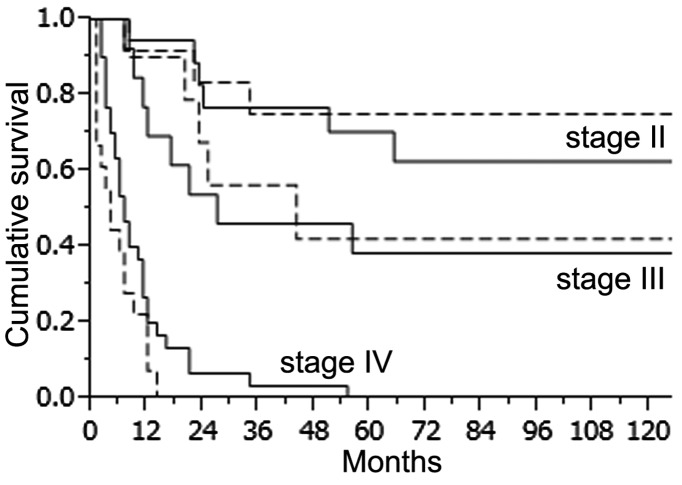
Survival curves for the younger group (YG) according to stage on patients treated with chemotherapy (CG, solid line) and patients not treated with chemotherapy (NCG, dashed line). The 5-year survival rate of the CG and NCG at stage II was 70.3 vs. 75.0% (P=0.646) and at stage III was 38.5 vs. 42.2% (P=0.568). The 2-year survival rate of the CG and NCG at stage IV was 6.7 vs. 0% (P=0.612).